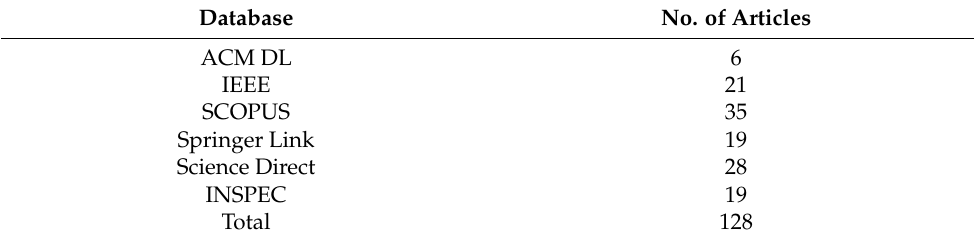
Table 1. Search databases and number of hit